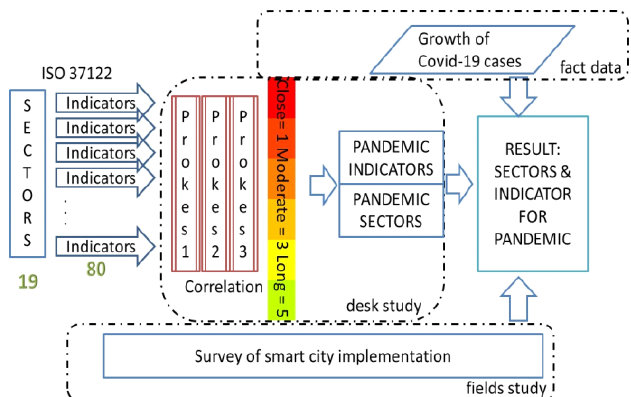
Figure 1. Overall research